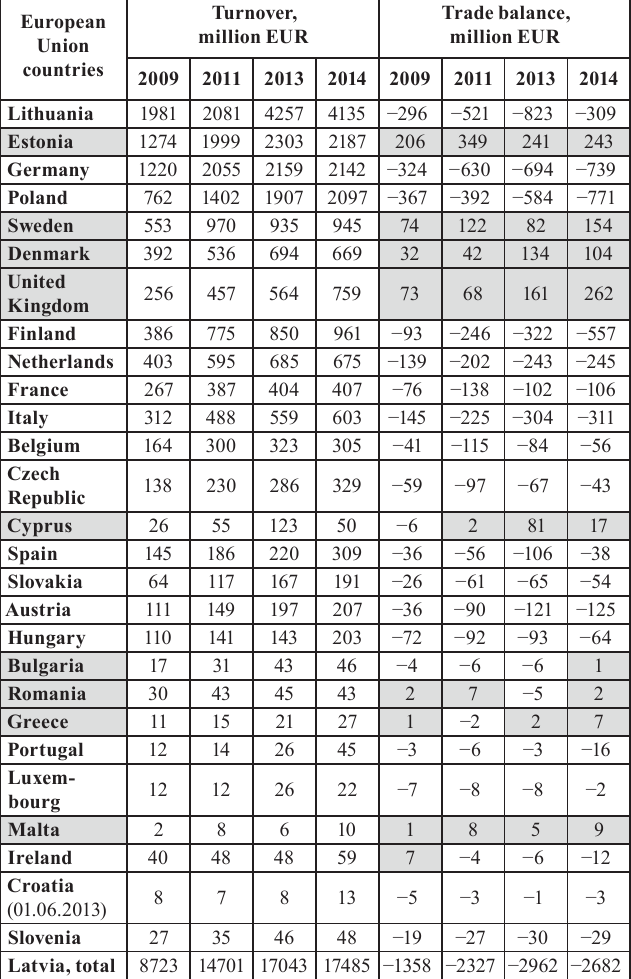
Latvia’s Goods Turnover Dynamics with the European Countries, Million